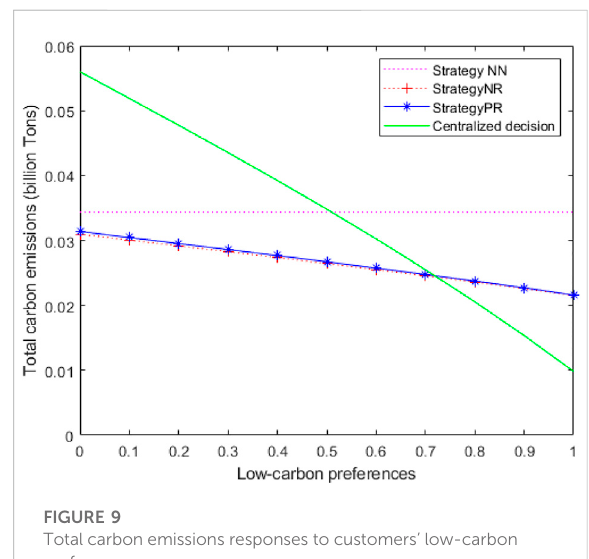
FIGURE 8 Optimal retail price responses to customers ’ low-carbon preference.